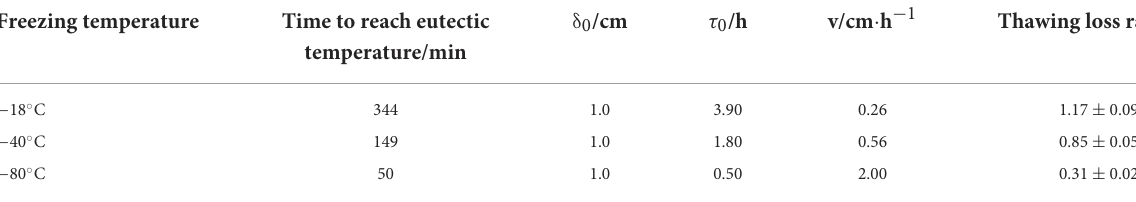
TABLE 1 Freezing features of different freezing temperature.